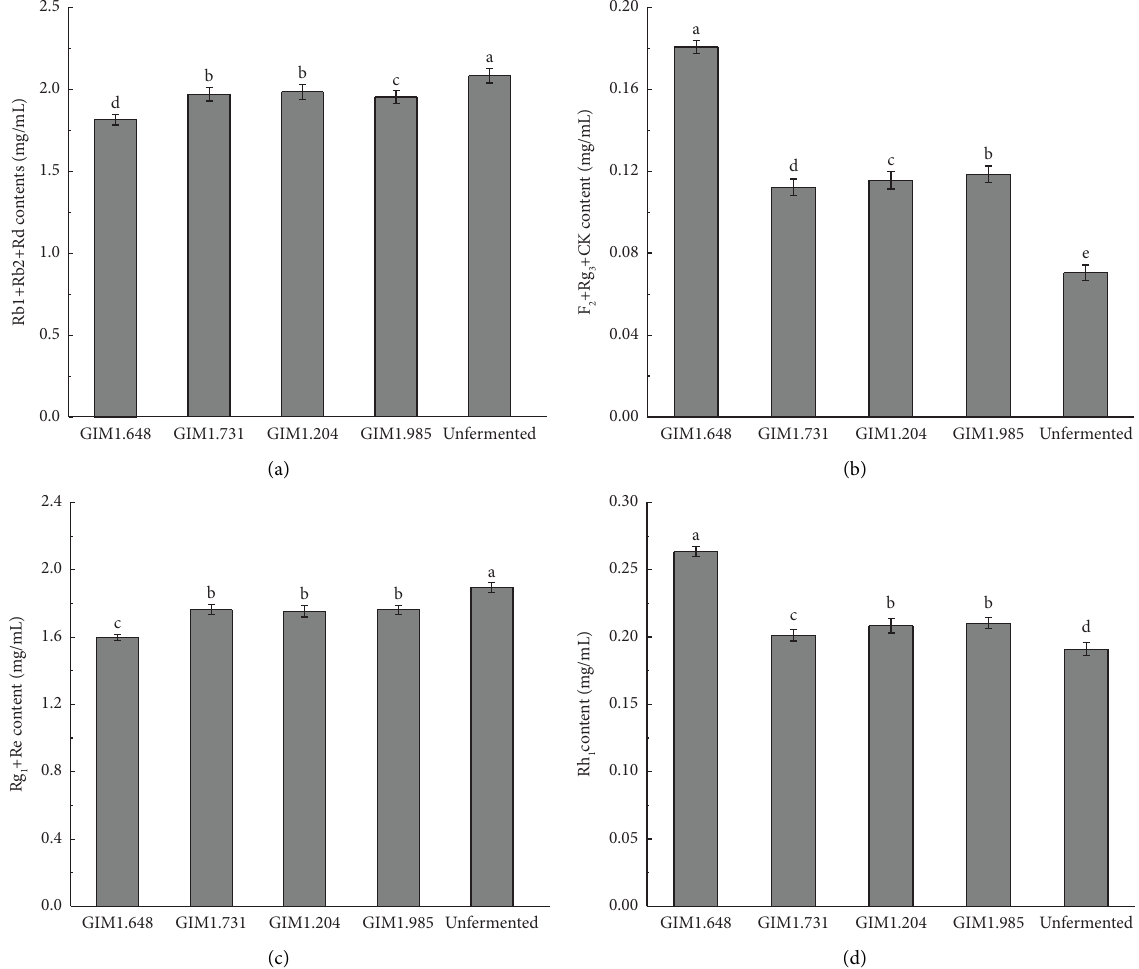
Figure 3: Changes in the content of ginsenosides in fermentation broth: (a) changes in content of diol saponins; (b) changes in content of triol saponins; (c) changes in content of conversion products of diol-type saponins; (d) changes in content of conversion products of triol- type saponins. Diferent letters indicate signifcant data diferences ( P < 0 .